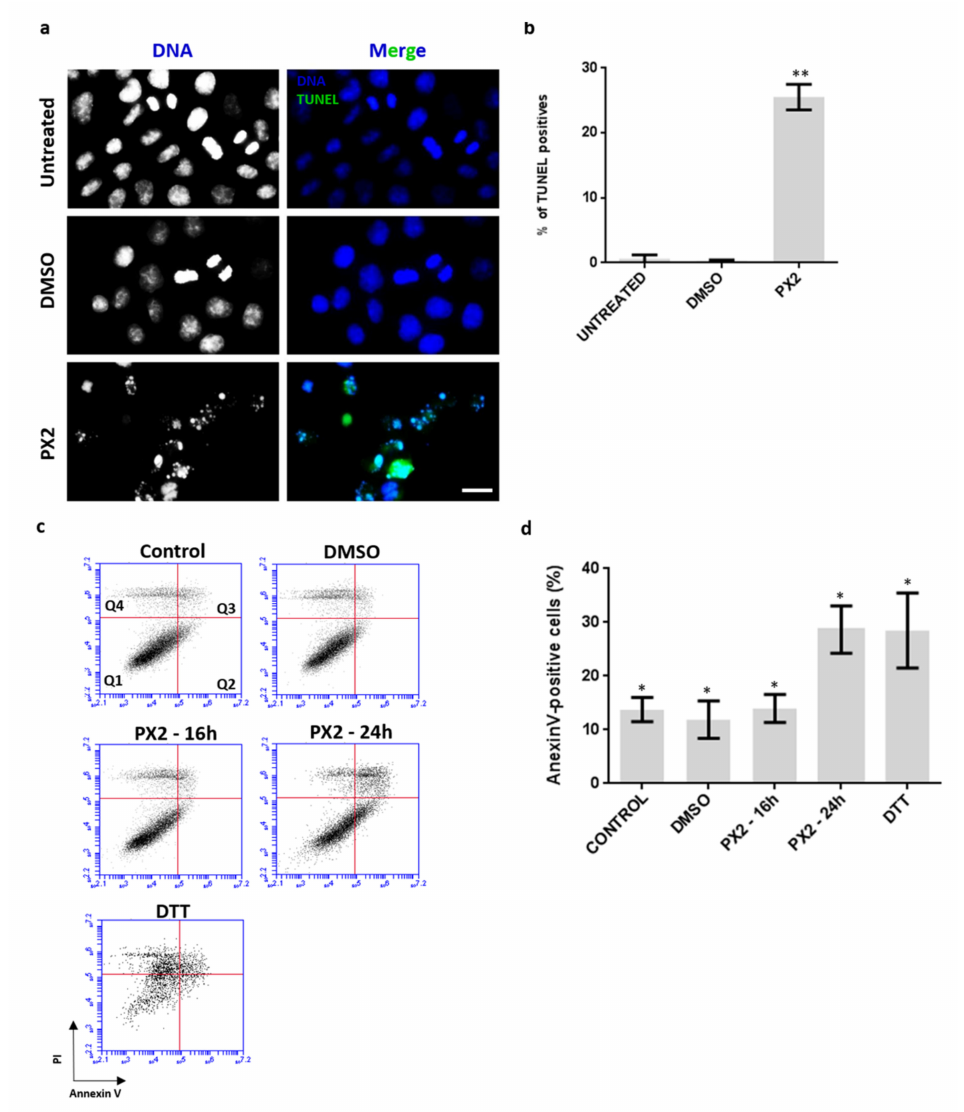
Figure 7. Prolonged exposure to pyranoxanthone 2 (PX2) leads to apoptotic cell death. ( a ) TUNEL staining showing accumulation of apoptotic cells (green) in cells treated with the compound for 48